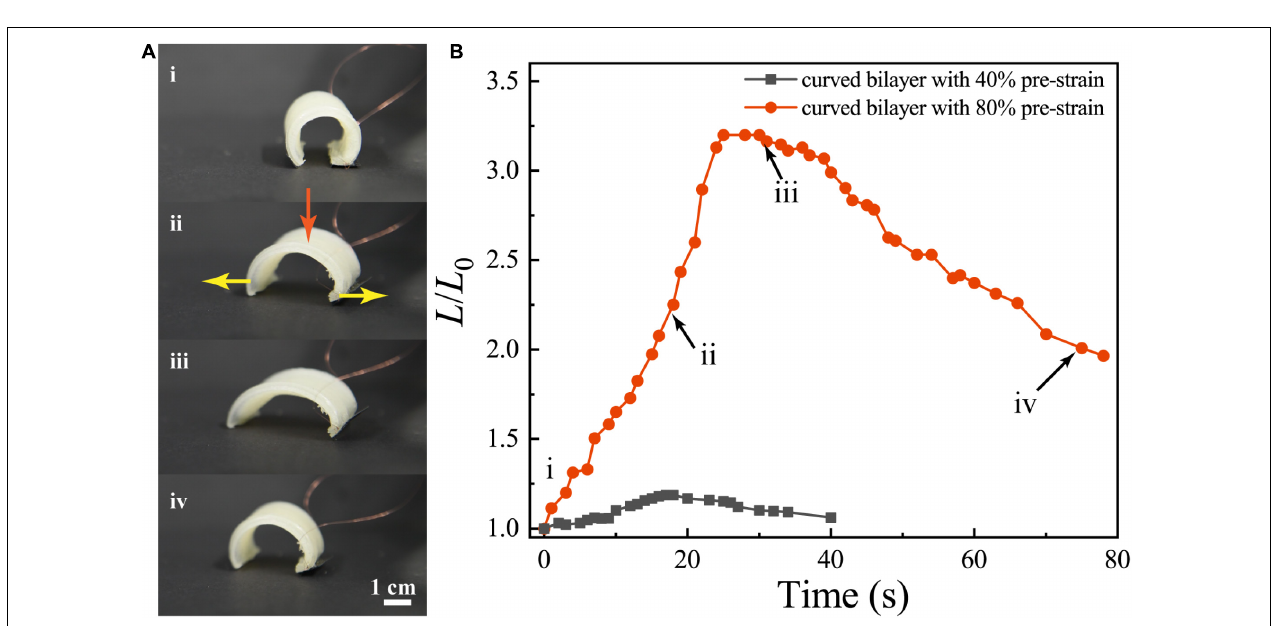
FIGURE 8 | Soft crawler based on 4D printing pre-strained bilayer. (A) Snapshot sequences for the crawler with 80 % pre-strain. (B) Deformation of the soft crawler as a function of time.